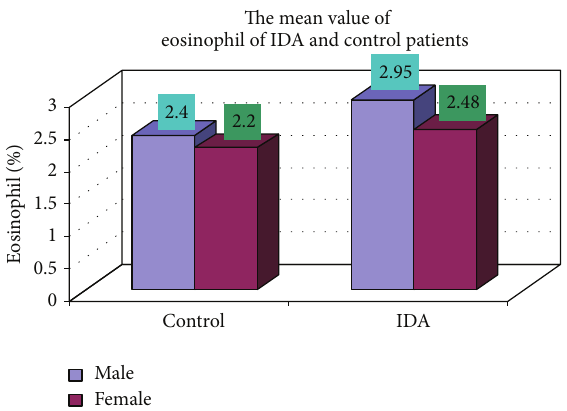
Figure 17: Showing mean value of eosinophil of control and iron deficiency anaemia.